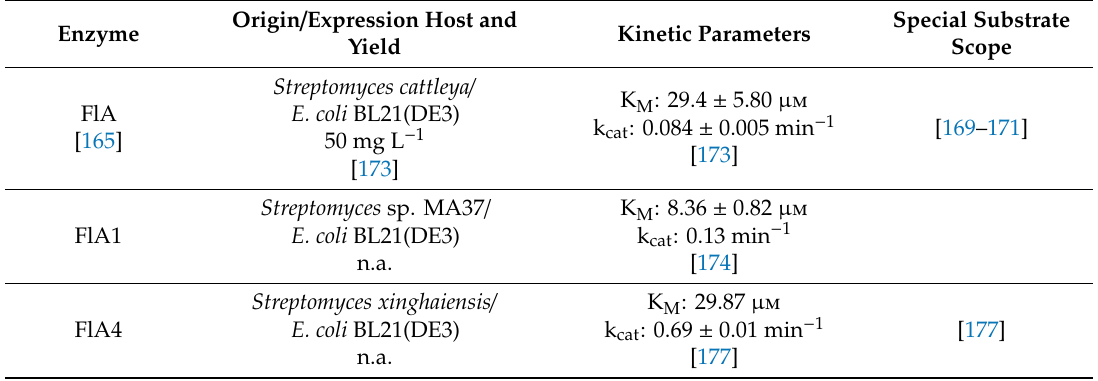
Table 5. Examples for heterologously expressed fluorinase. Kinetic data representing the conversion of 5 (cid:48) -ClDA into S -adenosylmethionine